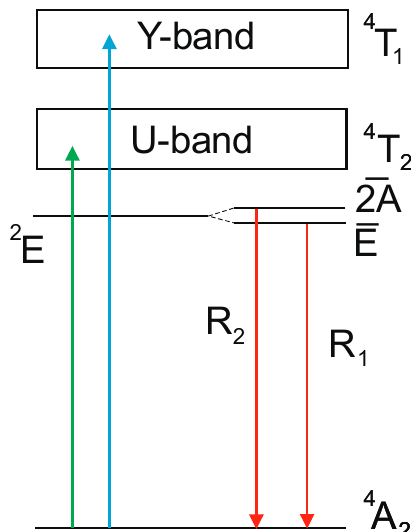
Figure 3. Simplified diagram of energy levels of Cr 3+ ion in oxide crystals. Vertical arrows show excitation and emission transitions.